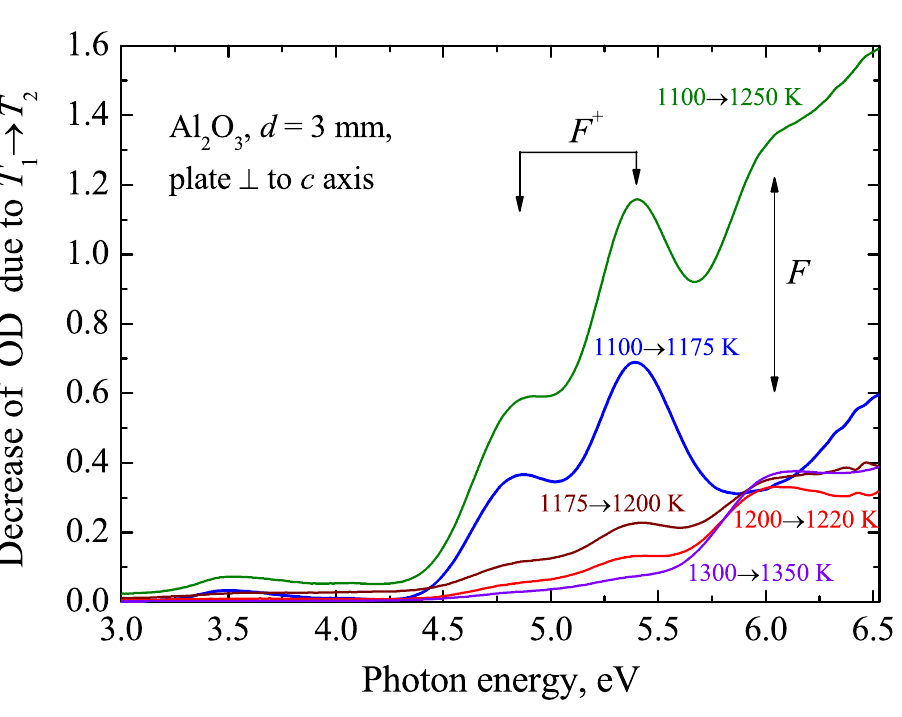
Figure 4. Difference spectra representing the decrease of RIOA due to the preheating of the neutron-irradiated Al 2 O 3 single crystal ( Φ = 6.9 × 10 18 cm -2 , RT, plate with d = 3 mm cut of perpendicular to main c axis) from T pr (1) to T pr